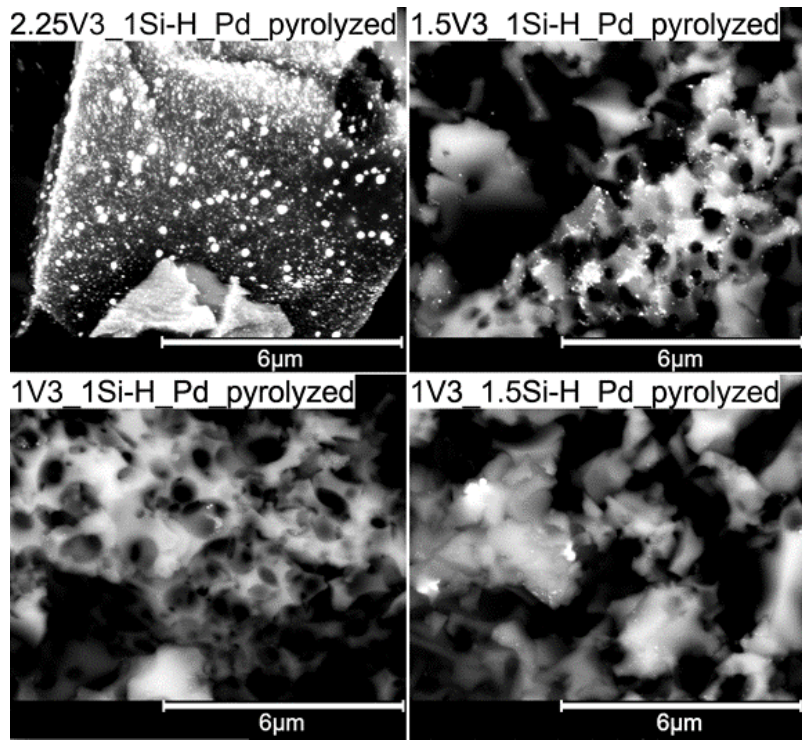
Figure 5. BSE images of Pd-containing samples after